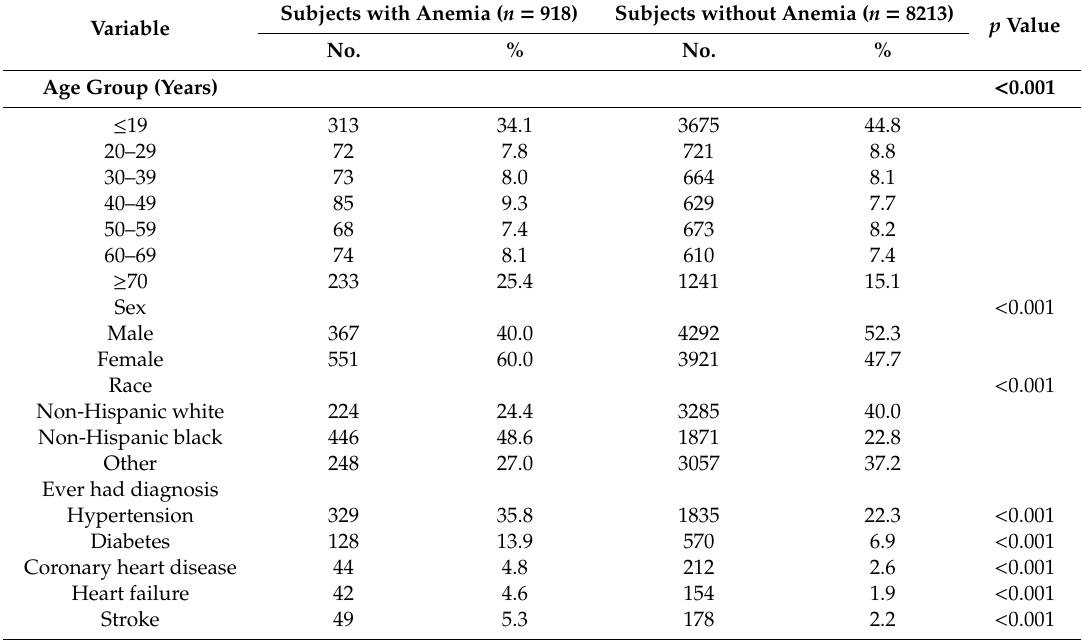
Table 1. Demographic characteristics and comorbidities of subjects with anemia and the controls without anemia ( n = 9131).